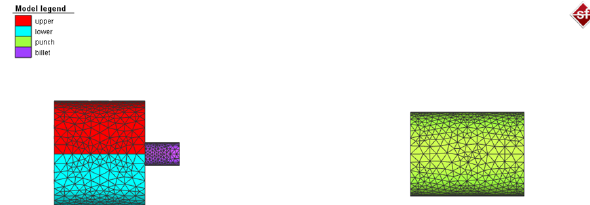
Figure 5: Meshing the geometry of the process